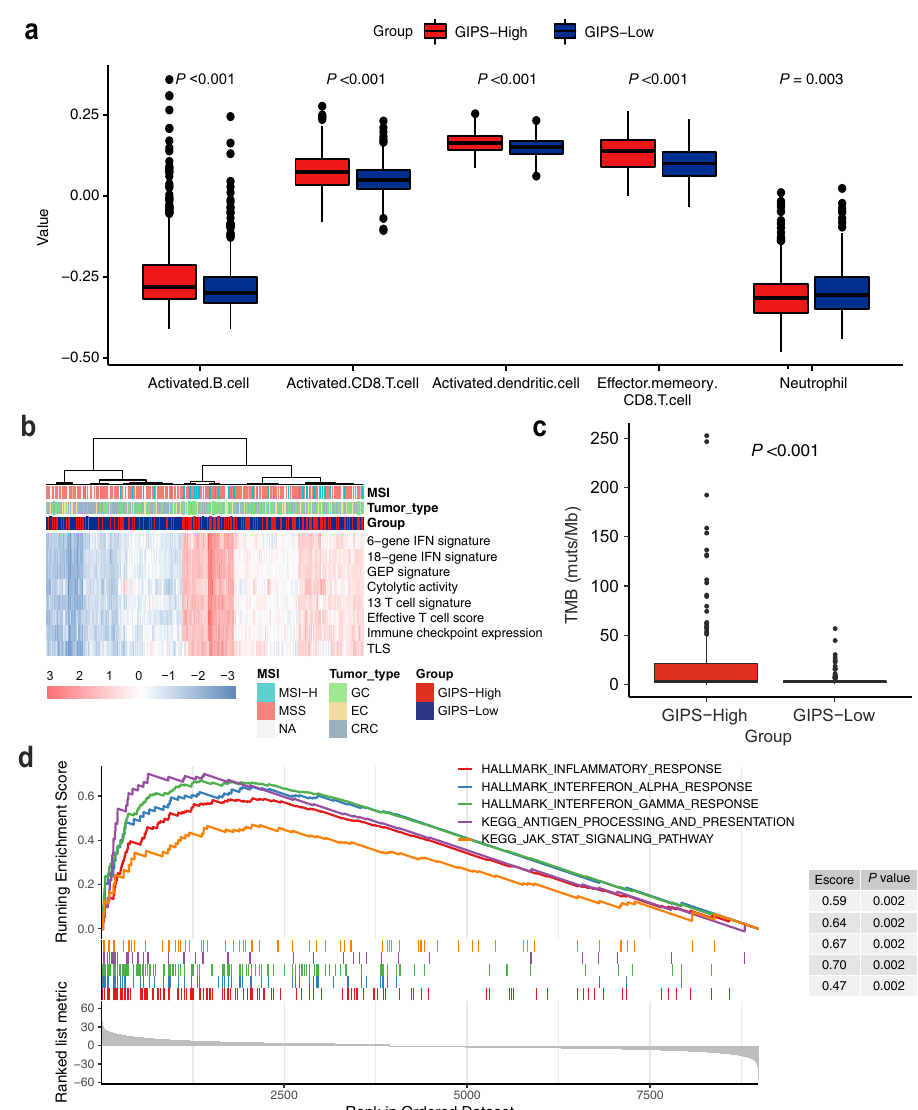
Fig. 4 Associations of tumor immune environment features with GIPS in the TCGA cohort. a Comparison of immune-cell in fi ltration according to GIPS status. b Heatmap of immune-related signatures in gastrointestinal cancers with GIPS-high and GIPS-low scores. c Comparison of nonsynonymous mutations between the GIPS-high and GIPS-low groups. d GSEA plot of immune-related pathways in comparisons between the GIPS-high and GIPS-low groups. Abbreviations: IFN, interferon; TLS, tertiary lymphoid